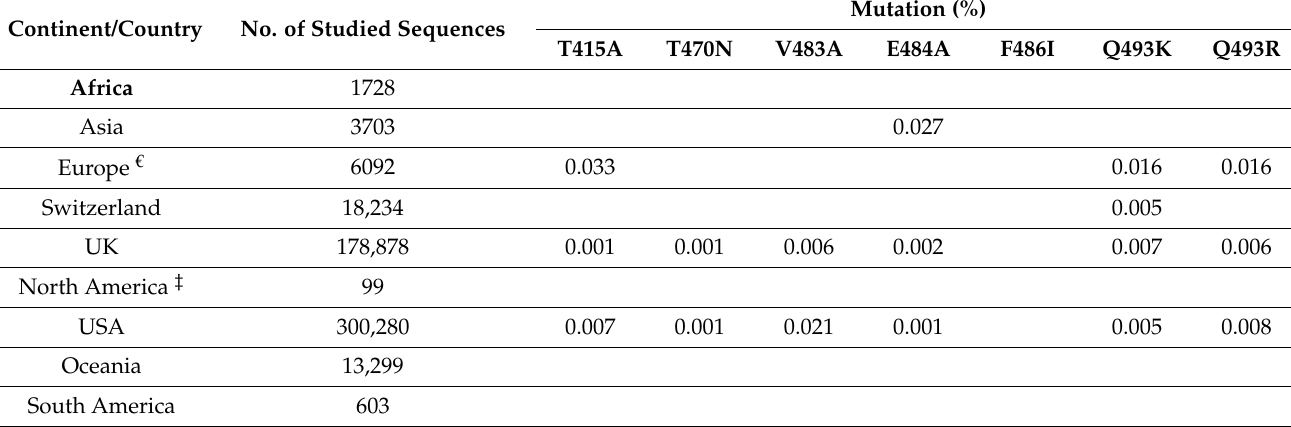
Table 3. Continent/country-wise prevalence of prolonged infections’ mutations in the receptor-binding domain of the SARS-CoV-2 spike protein until 29 May